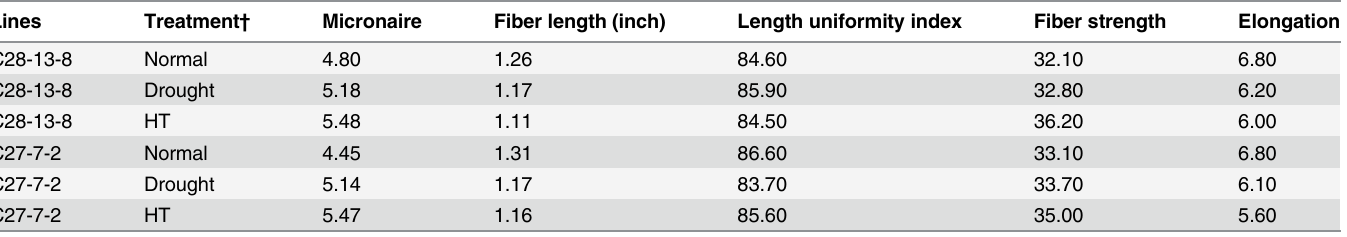
Table 3. High Volume Instrument analysis for major fiber quality traits of mature fibers harvested from greenhouse grown cotton lines under nor- mal and stressed conditions.